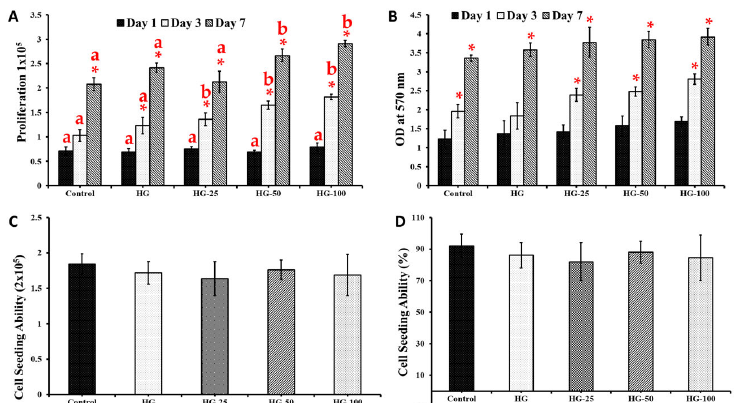
Figure 3. Proliferative ( A ), cytotoxic ( B ), and cell-seeding ability ( C , D ) of VEGF-loaded collagen– chitosan hydrogels. Control: cells without hydrogels, HG: hydrogels without VEGF, HG − 25, HG − 50, and HG − 100: hydrogels with 25 ng/mL, 50 ng/mL, and 100 ng/mL of VEGF, respectively. * and different alphabets denote statistical significance, * vs. day 1 and different alphabets vs. control group, respectively, p < 0.05.